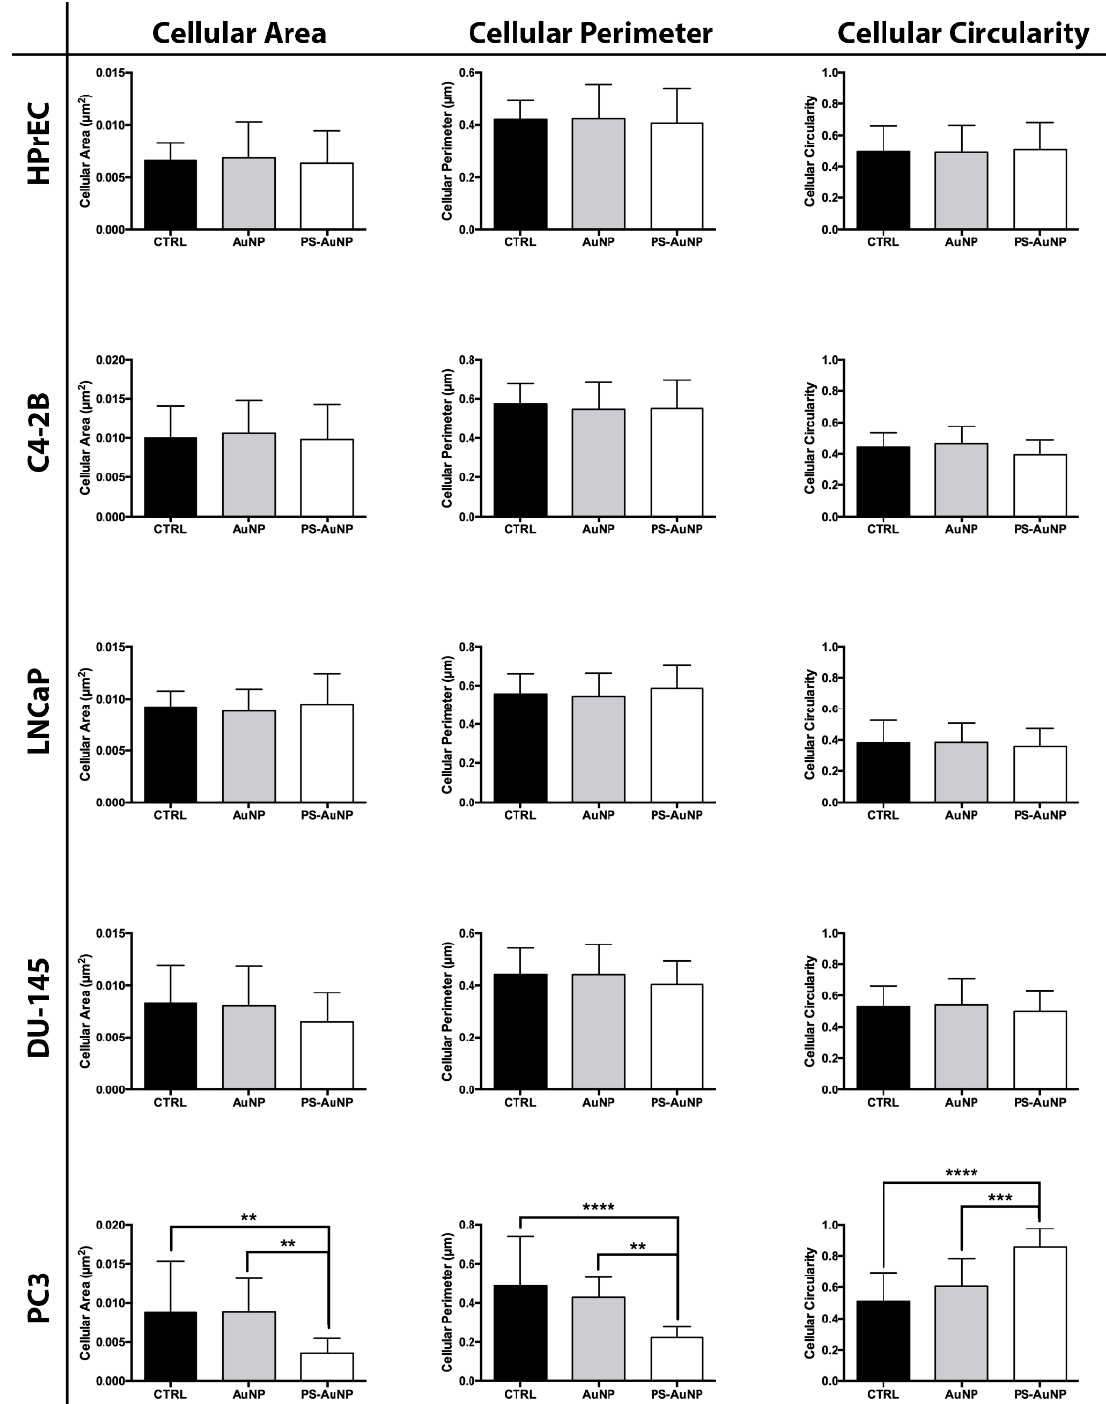
Figure 6. PS-AuNPs induce significant decreases in cellular area and perimeter and significant increases in cell circularity in prostate cancer (PC3) cells, compared to PBS (control) and AuNP-challenged cells, but not in normal prostate (HPrEC) cell line. Cellular Area (left), Cellular Perimeter (Center), and Cell Circularity (Right) of the HPrEC normal prostate cell line and the prostate cancer cell lines C4-2B, LNCaP, DU-145, and PC3. ** means p < 0.01 between the annotated samples; *** means p < 0.001 between the annotated samples; and **** means p < 0.0001 between the annotated samples.